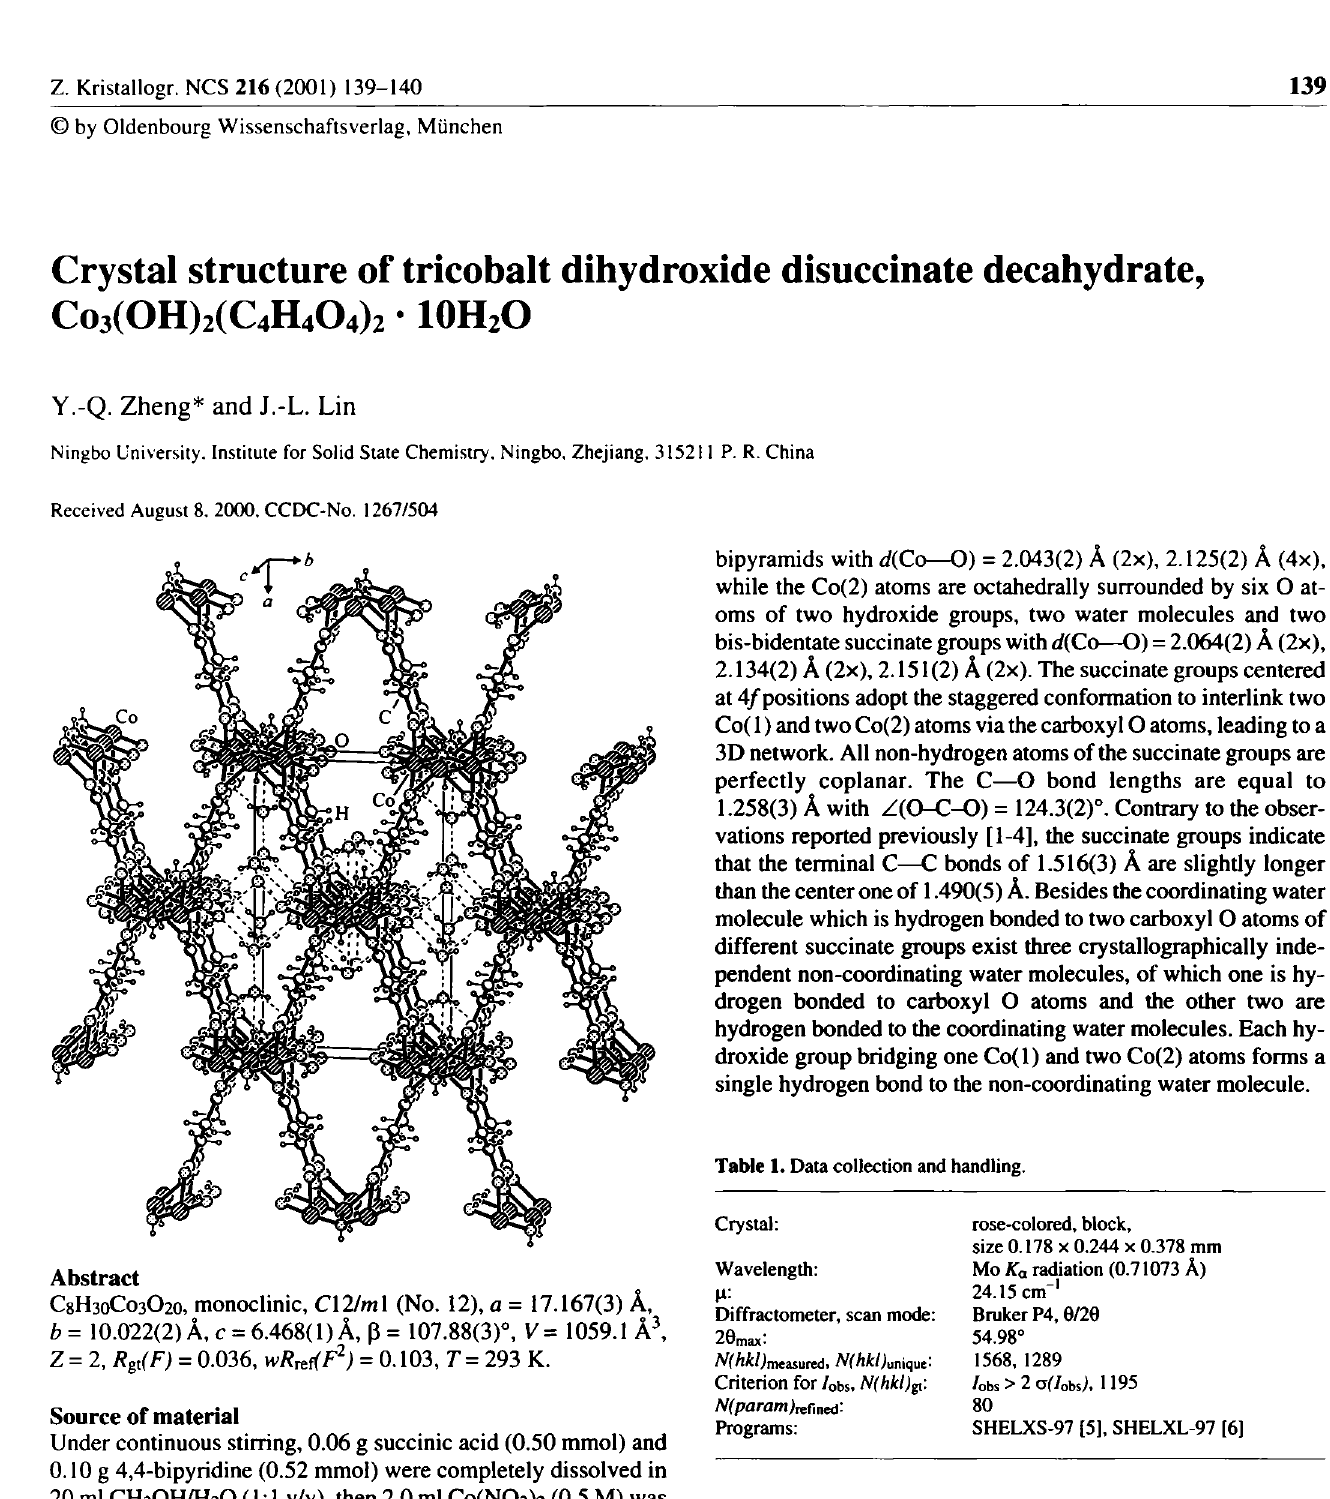
Table I. Data collection and handling.